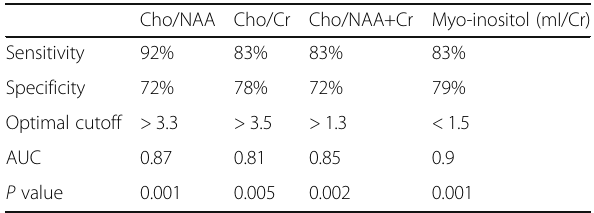
Table 3 ROC curve analysis of the metabolite ratios for the prediction of high-grade neoplastic